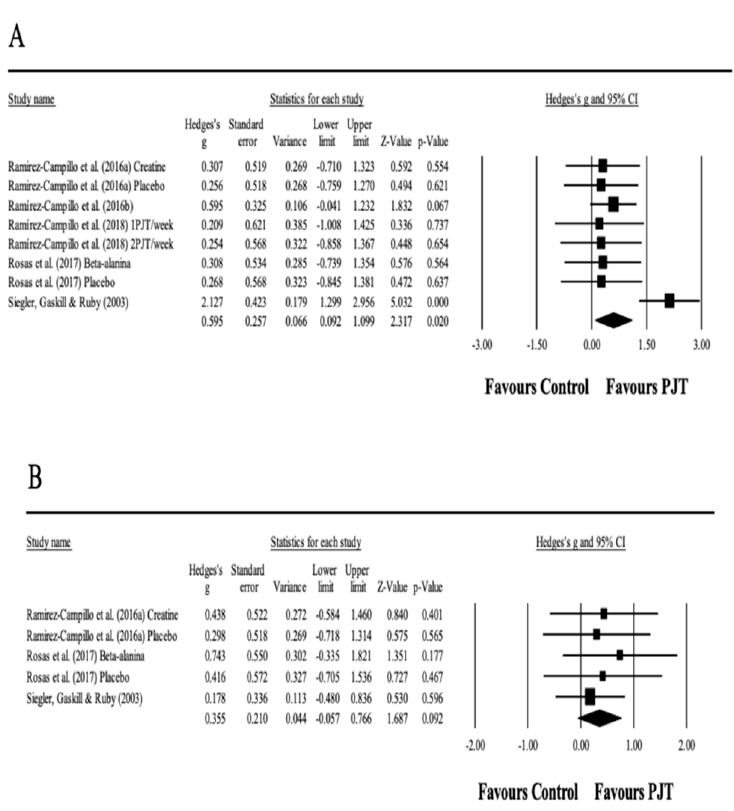
Figure 5. Forest plot of changes in endurance performance ( A ) and anaerobic performance ( B ), in athletes participating in plyometric jump training (PJT) compared to controls. Values shown are effect sizes (Hedges’s g) with 95% confidence intervals (CI). The size of the plotted squares reflects the statistical weight of the study. Split figure and place ( B ) under ( A ) to fit on the page.